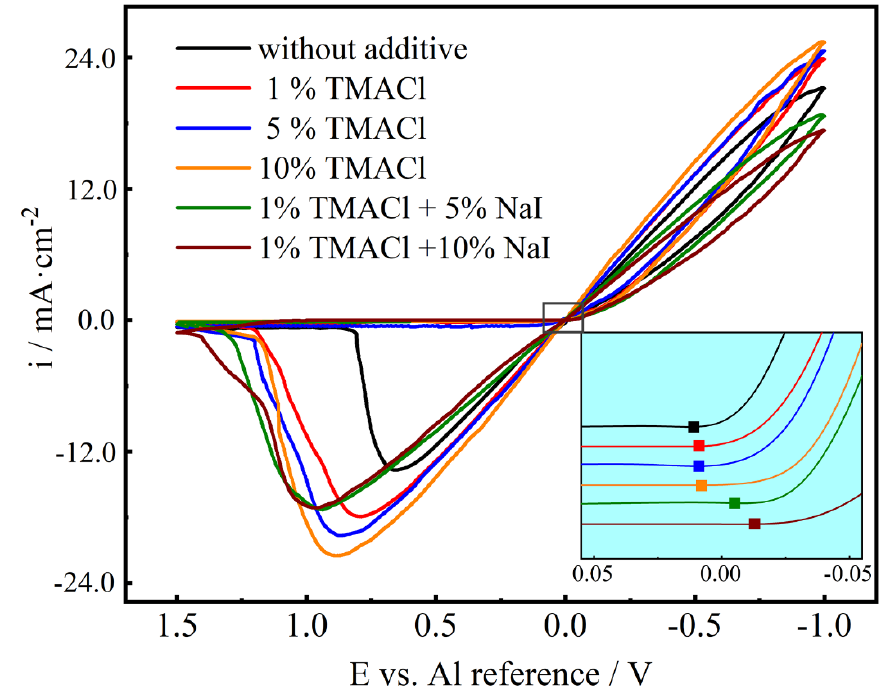
Figure 2. The cyclic voltammograms of the AlCl 3 -NaCl-KCl molten salts electrolyte without additive, 1% TMACl, 5% TMACl, 10% TMACl, 1% TMACl + 5% NaI and 1% TMACl + 10% NaI, at 150 °C.